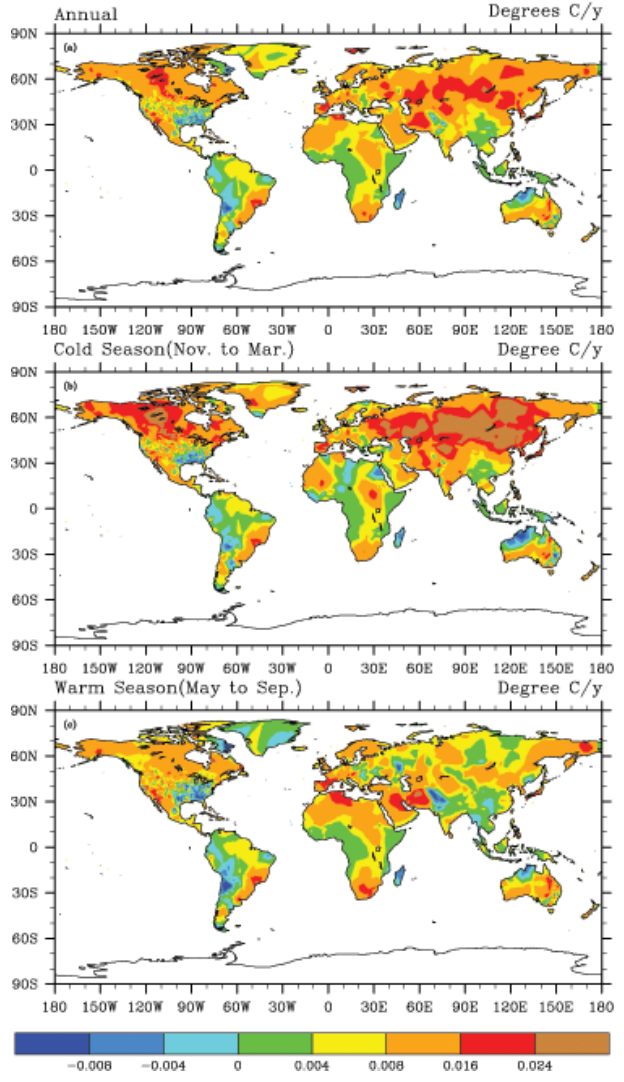
Fig. 2. Global distribution of linear land surface temperature trend in the period of 1901–2009 for (a) Annual, (b) Cold season (November to March), and (c) Warm season (May to September) (unit: ◦ Cyr − 1 ).